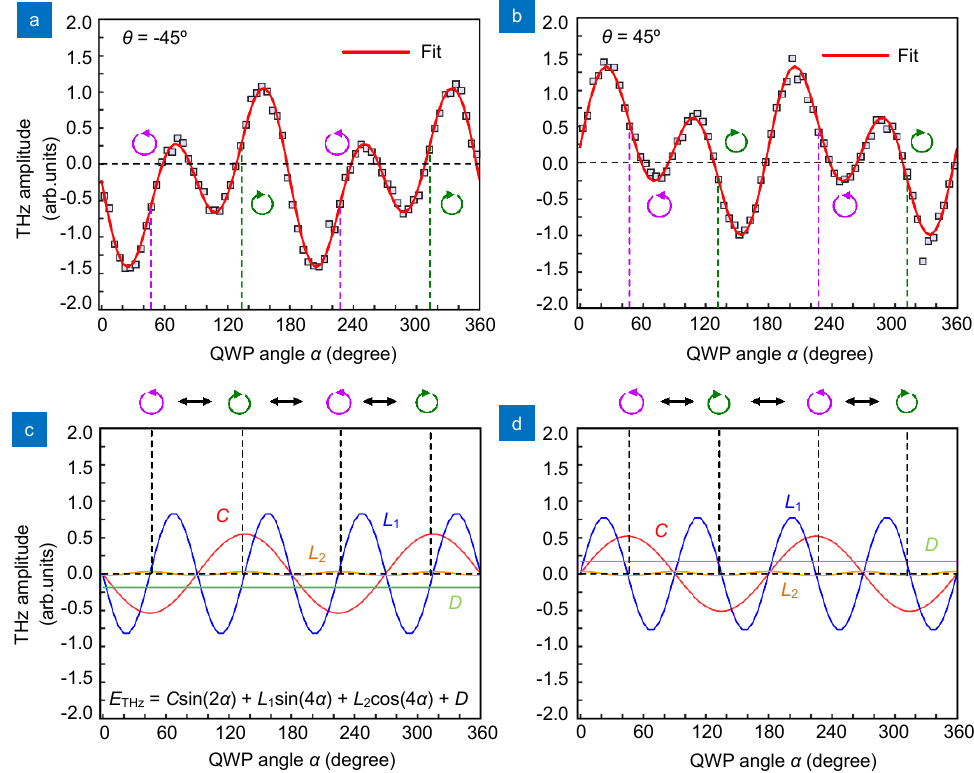
Fig. 4 | ( a ) and ( b ) represent the α -dependent terahertz amplitude at t = 2.46 ps. The red solid lines are the best fit with Eq. (2). The symbol ↔ , the counterclockwise arrow ↺ , and the clockwise arrow ↻ denote linearly polarized (black: α = 0°), left-hand circularly polarized (pink: α = 45°), and right-hand circularly polarized (green: α = 135°) incident photons, respectively. ( c ) and ( d ) display the α -dependent coefficients C (red line) , L 1 (blue line) , L 2 (orange line), and D (blue line) extracted [using Eq. (2)] individually from (a) and